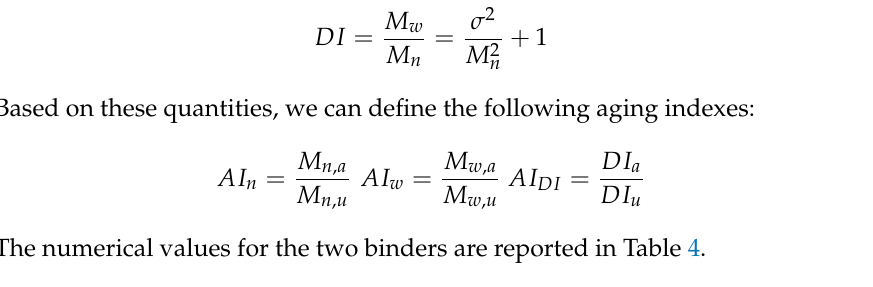
Table 4. Average molecular weights, dispersion, and aging indexes for B and